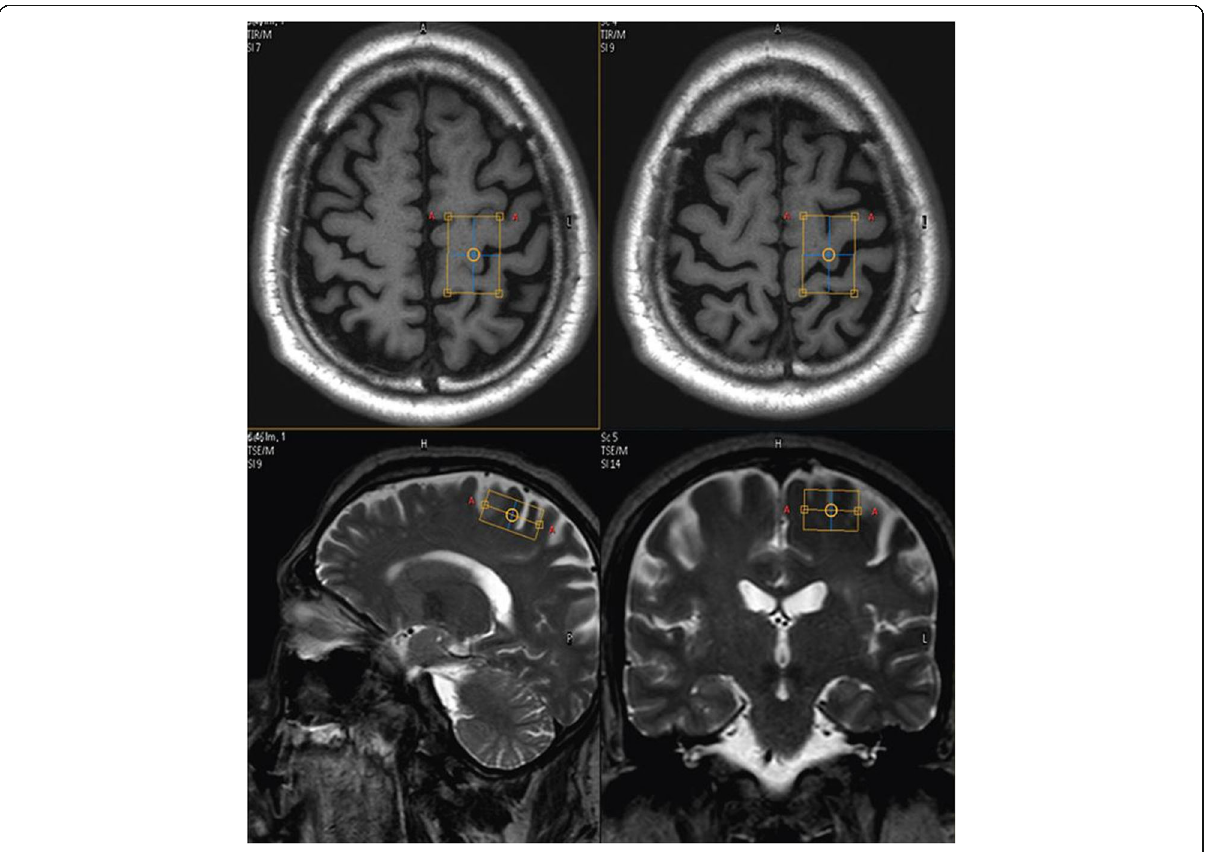
Fig. 1 Precentral gyrus, which represents the M1 of hand area (landmark of precentral gyrus), determined anatomically by the area that faces and forms the “ middle knee ” of the central sulcus, located just at the cross point between the precentral sulcus and the central sulcus, which is topographically located at the level of the distal end of the superior frontal sulcus and is therefore also visible on the cortical